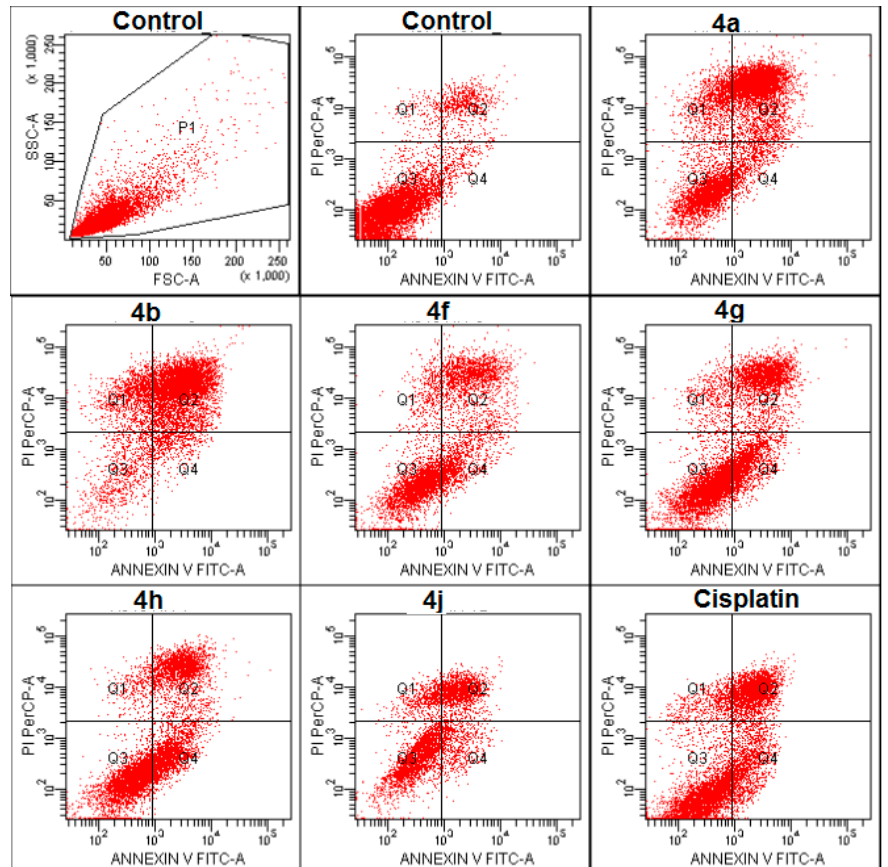
Figure 6. Flow cytometric diagrams of A549 cells treated with compounds 4a , 4b , 4f , 4g , 4h , 4j and cisplatin.